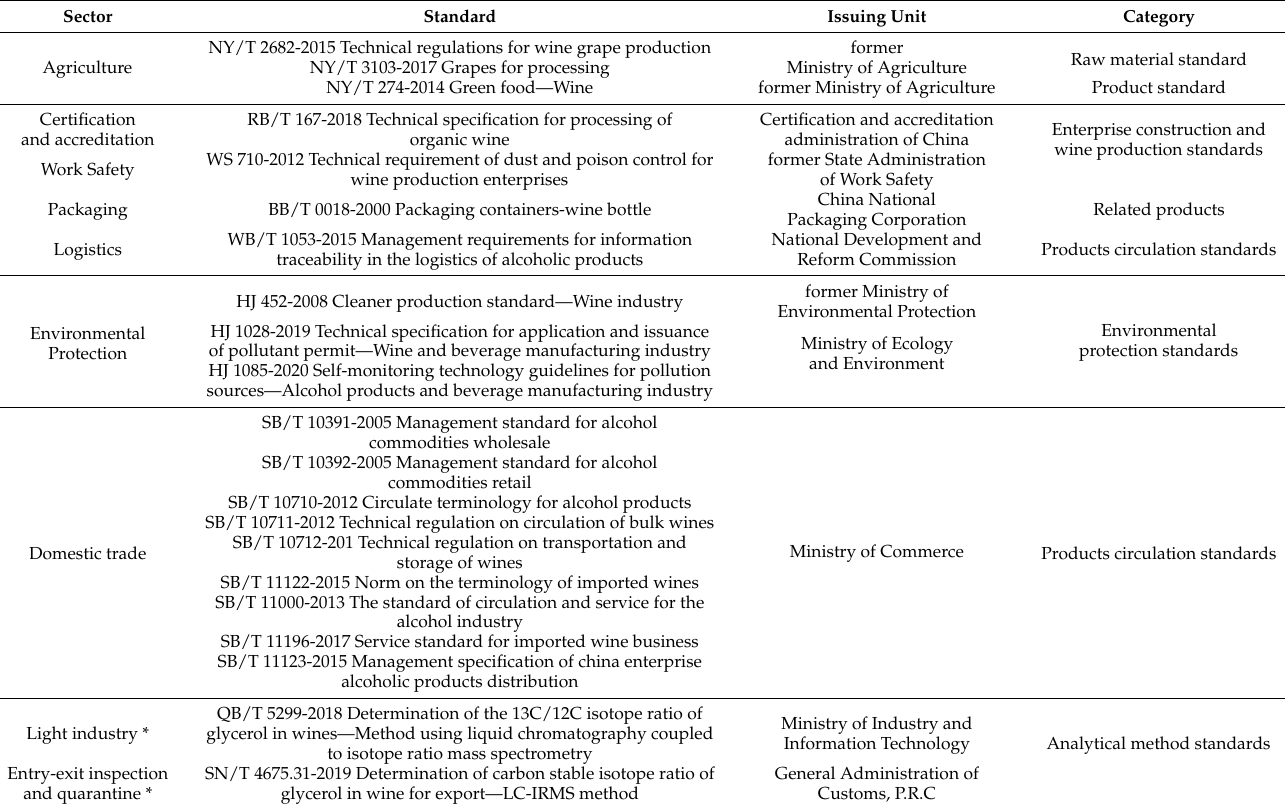
Table 8. Sector standards in wine-related